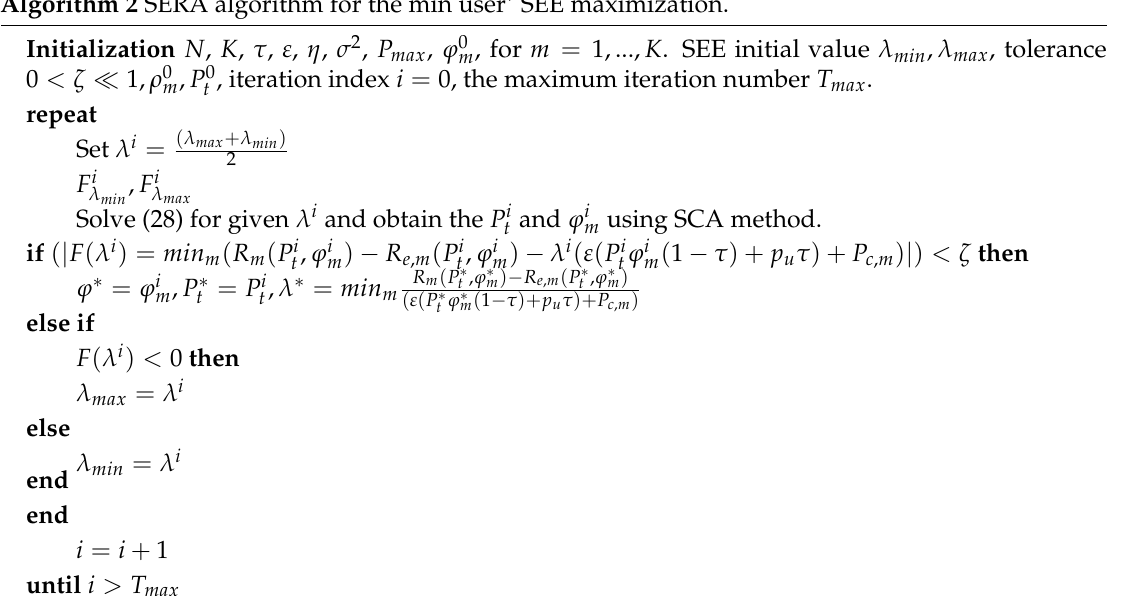
Algorithm 2 SERA algorithm for the min user’ SEE maximization.